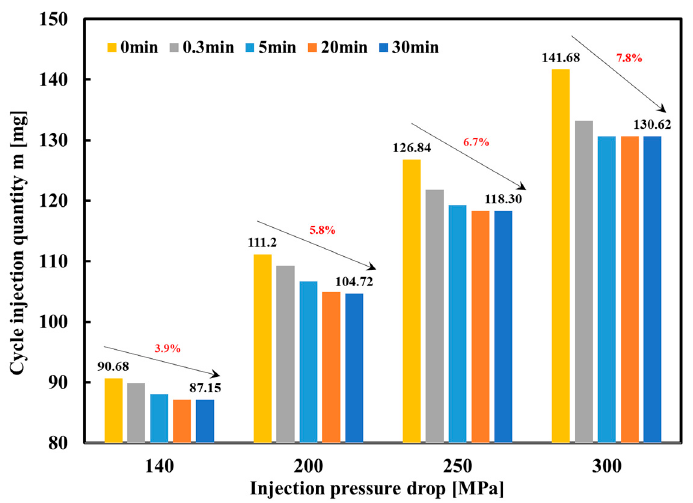
Figure 12. Change in the cycle injection quantity calculated with consideration of the thermal